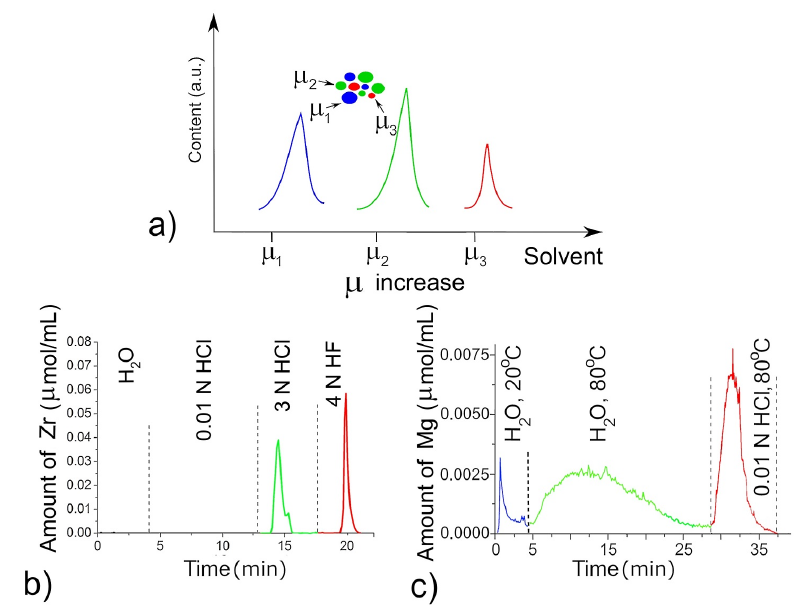
Figure 1. Differential dissolution of the phases with chemical potentials µ 1 – µ 3 from a model three- phase mixture ( a ); dissolution of defective (green) and stoichiometric (red) ZrO 2 species ( b ) and dissolution of defective (green) and stoichiometric (red) MgO species ( c ).